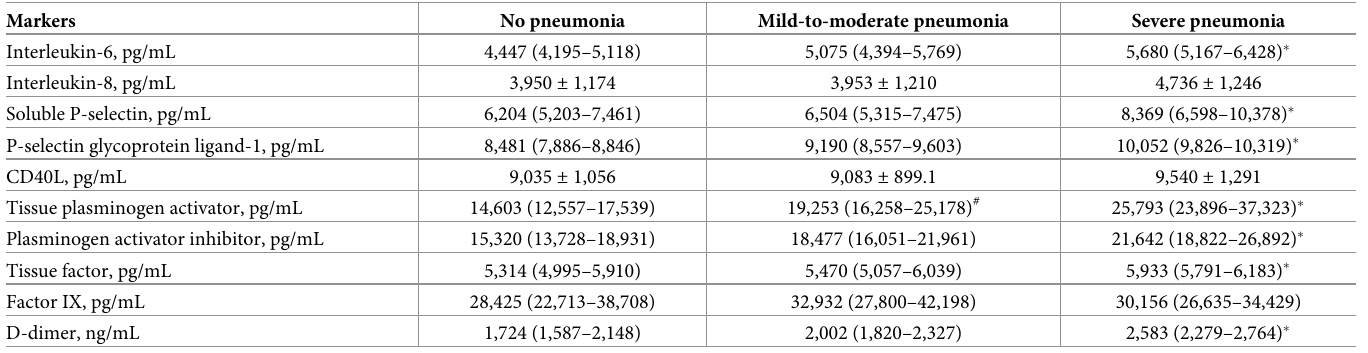
Table 2. Soluble inflammatory and thrombotic markers on the admission